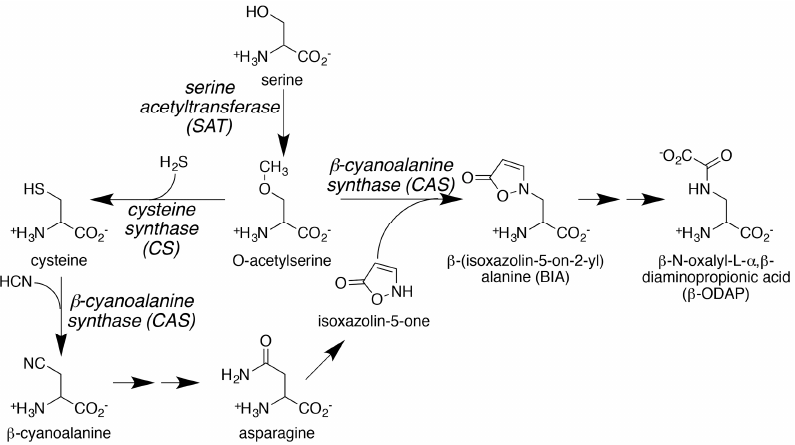
Figure 2. β - N -oxalyl- L - α , β -diaminopropionic acid ( β -ODAP) biosynthetic pathway in grass